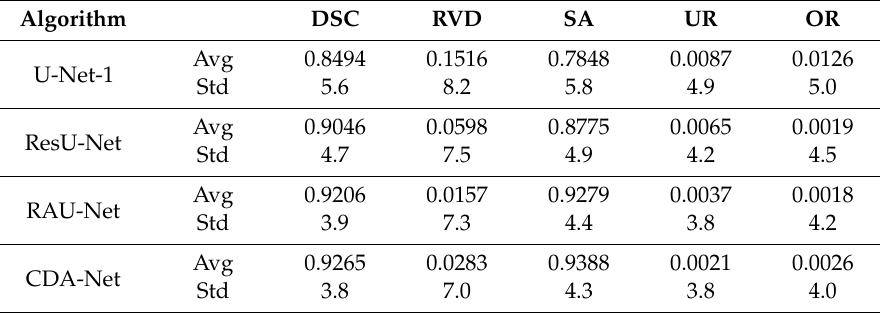
Table 4. Evaluation results of four algorithms on ASPS13.